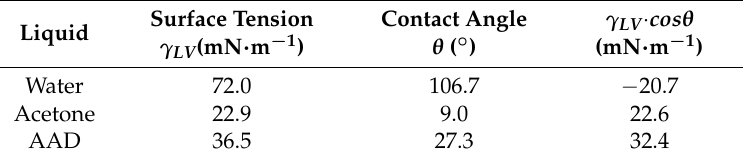
Table 2. The surface tension at 25 ◦ C and 1 atm, and the contact angle to the CNT films of three